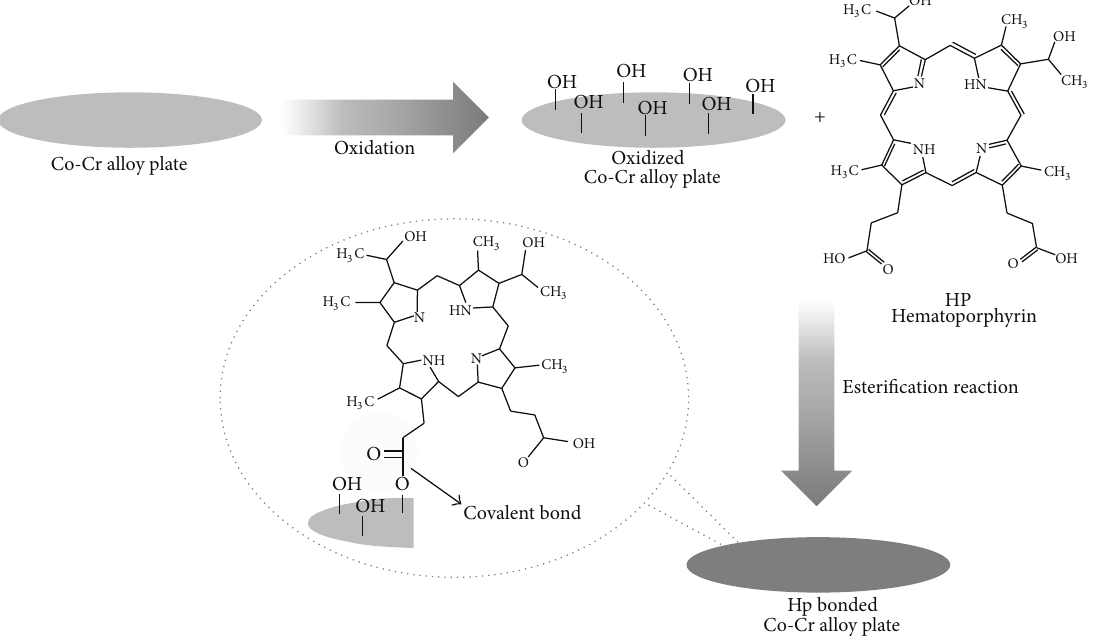
Scheme 1: Fabrication procedure of the photofunctional Co-Cr alloy